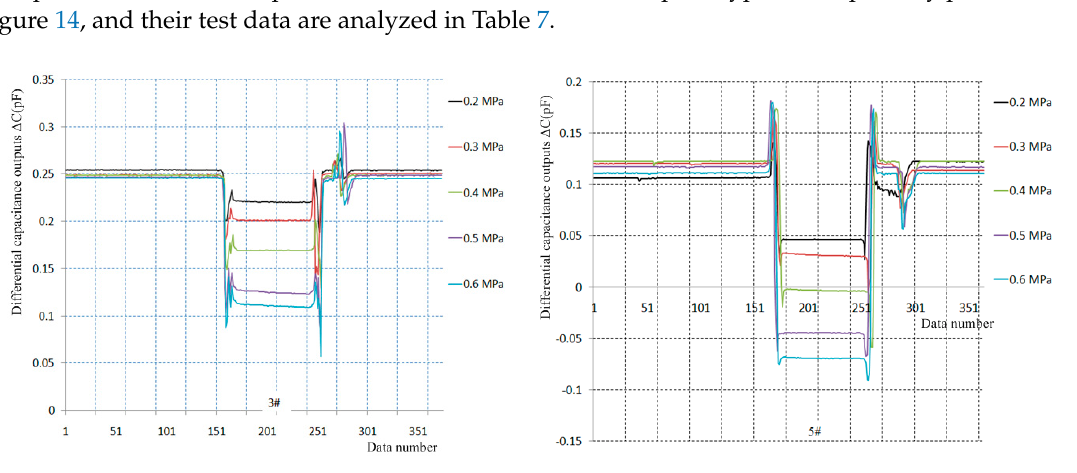
Figure 14. Dynamic calibration curves under laminar flow conditions.